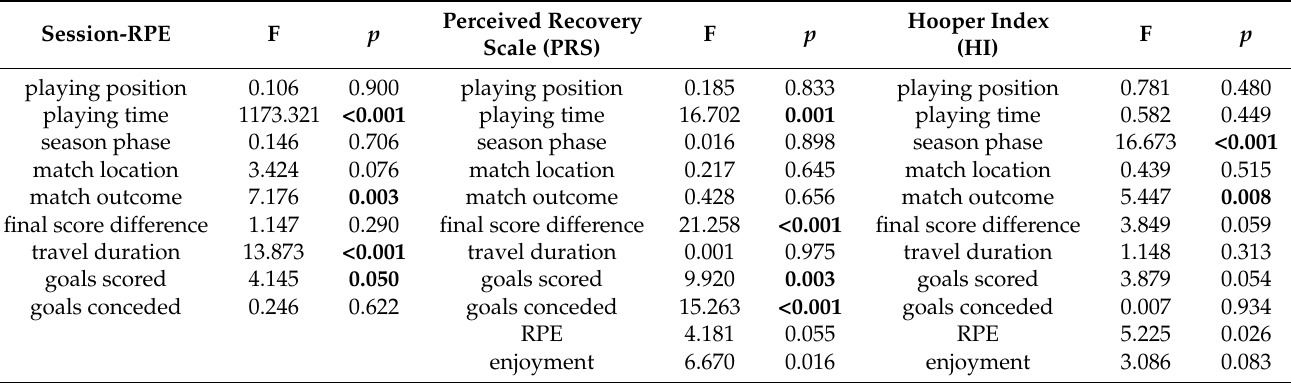
Table 3. Results of the main effect analysis